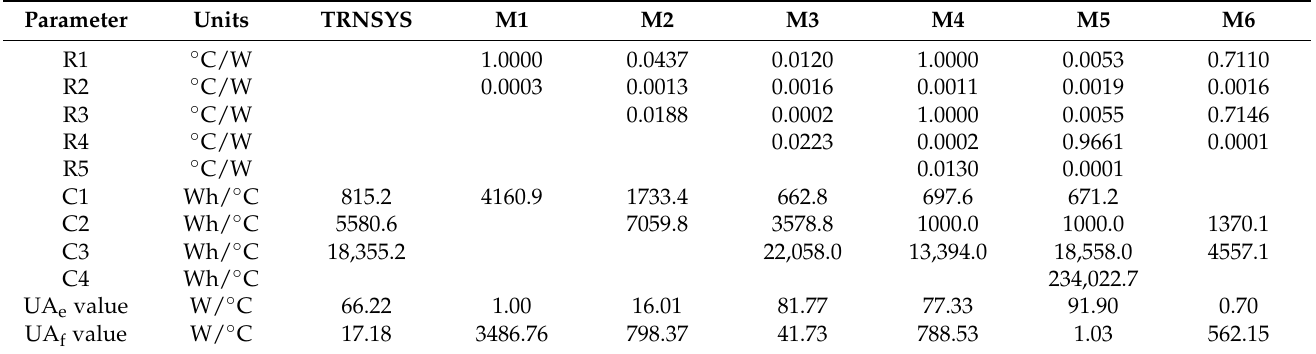
Table 3. Identified parameters and calculated UA value of each model from the TRNSYS